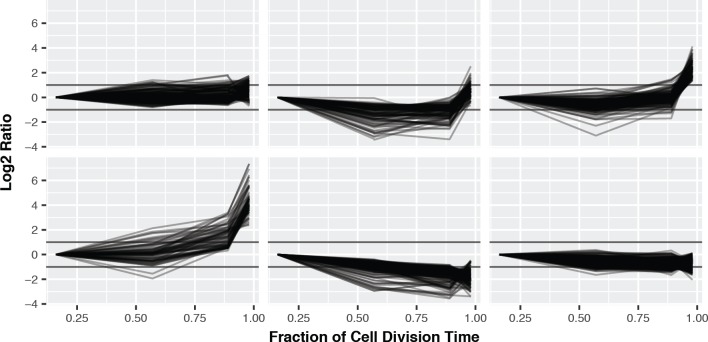
K-means clustering of the phosphorylation profiles normalised to total protein abundance.